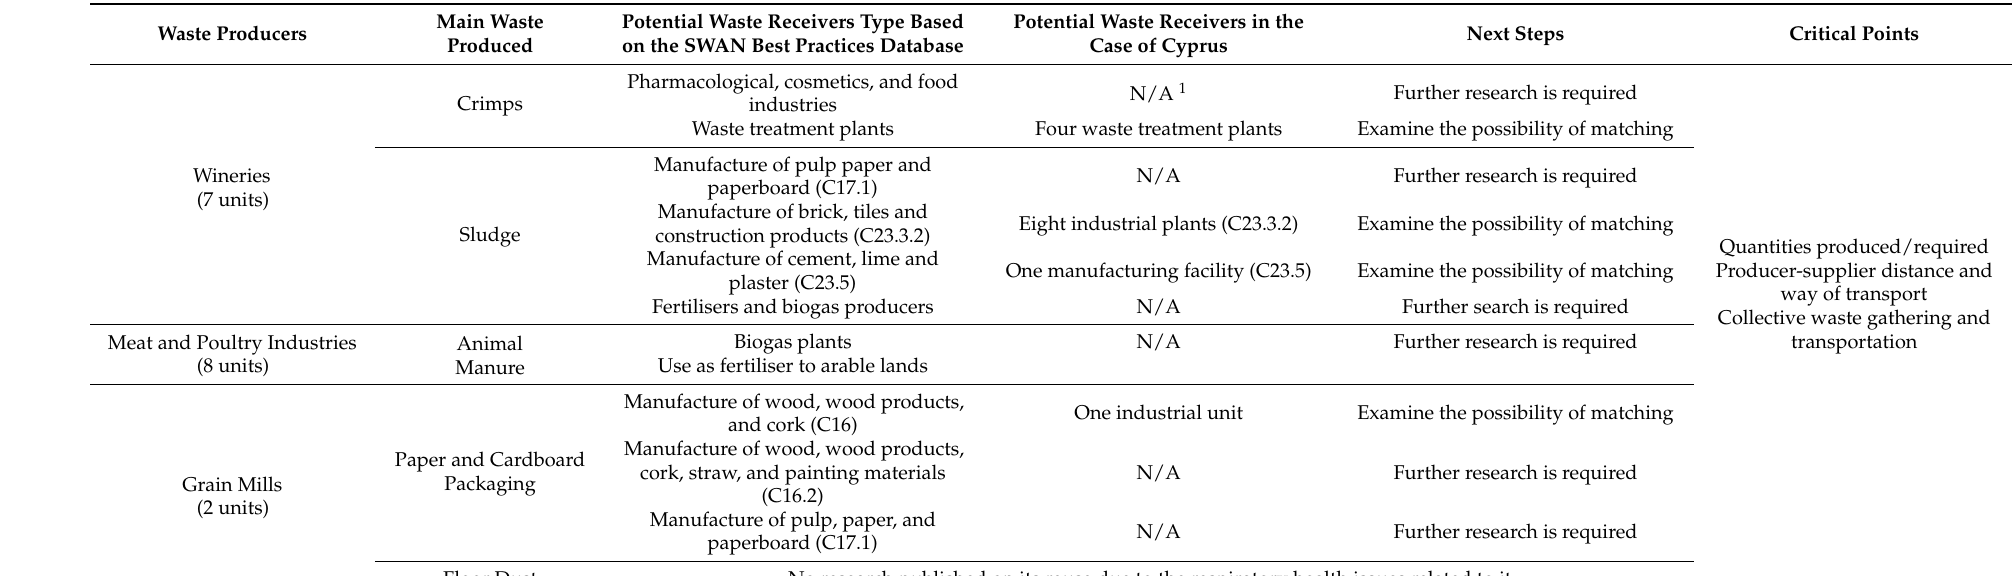
Table 4. Potential circular business